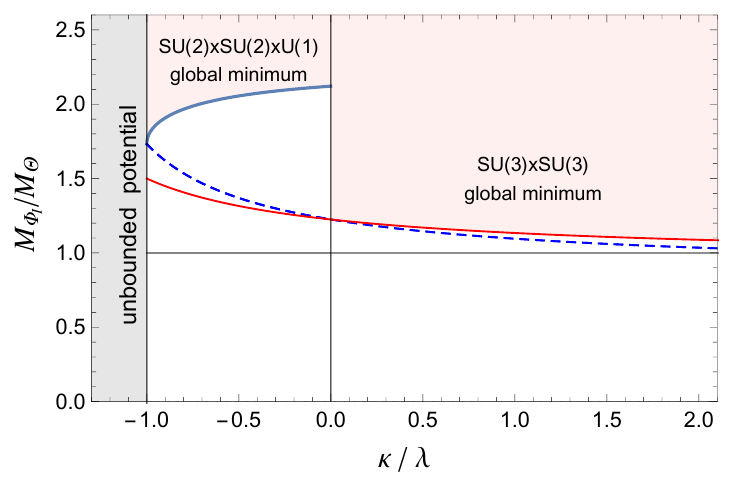
(cid:30) I =M (cid:2) as a function of =M (cid:2) is given by the solid I > 0 and (cid:20) < 0; the dashed blue line (cid:6)